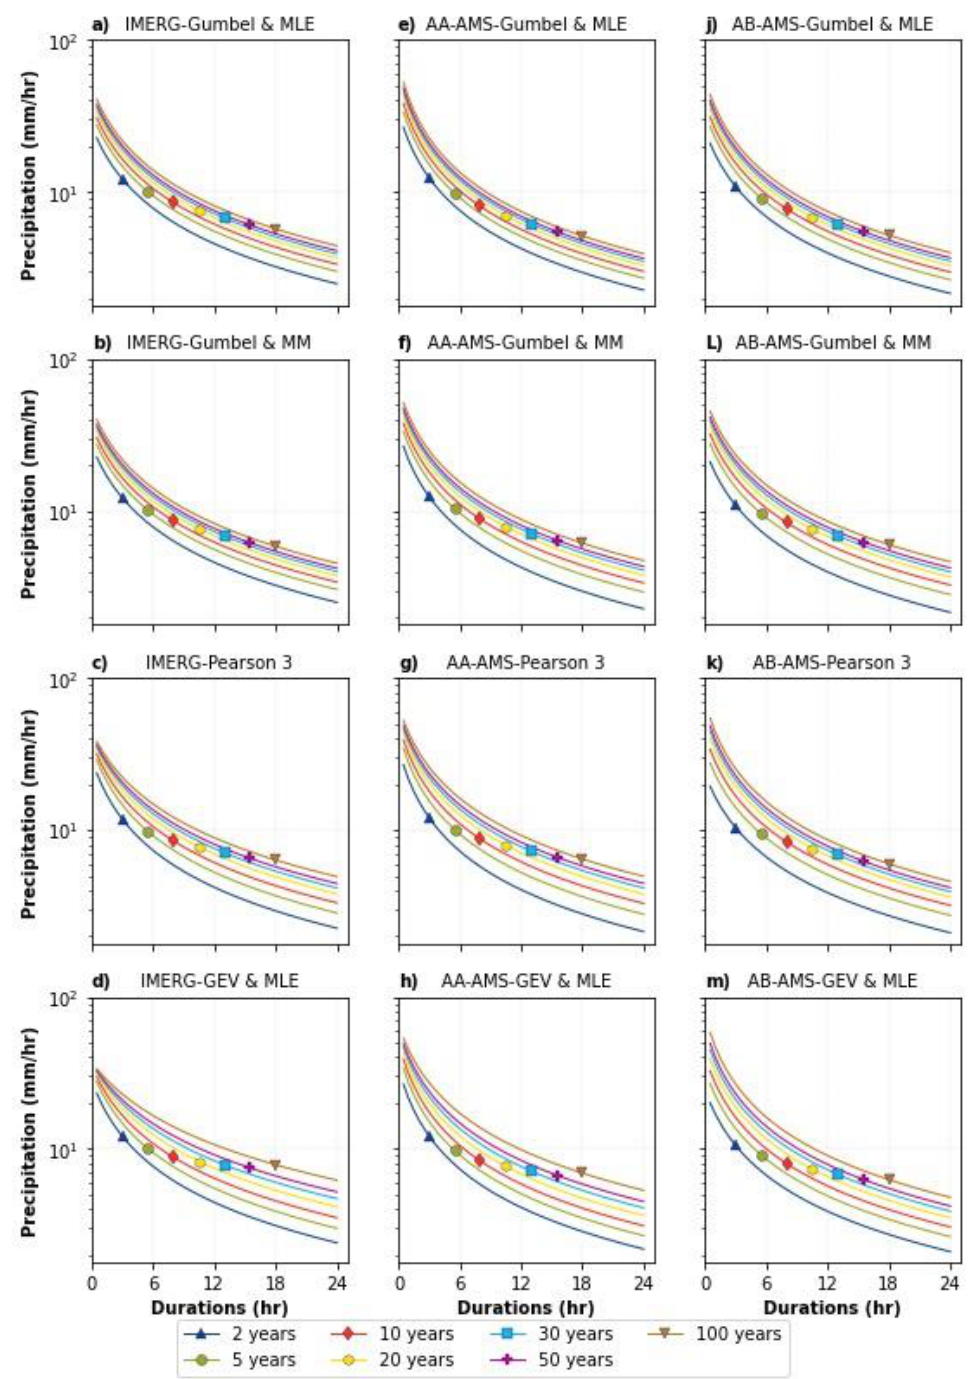
Figure A7. IDF curves fitted with the four CDFs over FBR 2 for the 2, 5, 10, 20, 30, 50, and 100 year return periods and durations from half-hour to 24 h. From left to right : IMERG, AA-AMS, and AB-AMS. From top to bottom : Gumbel and MLE, Gumbel and MM, Pearson 3, and GEV and MLE The marker’s purpose is only to distinguish the IDF curves.